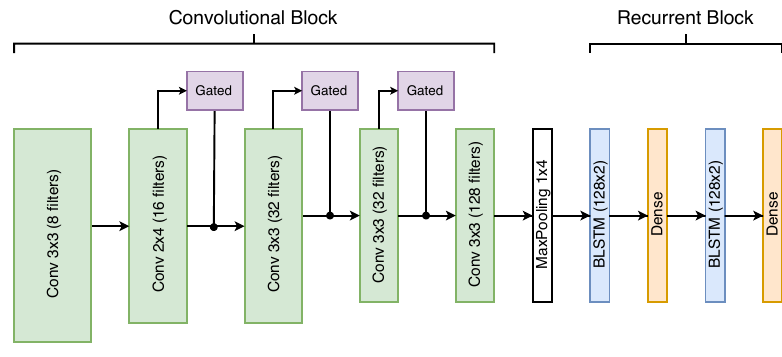
Figure 6. Bluche architecture